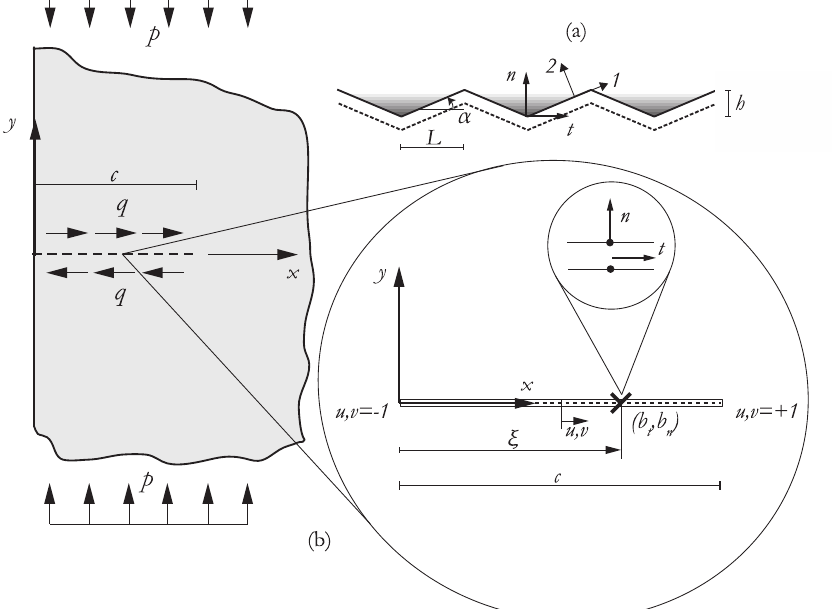
Figure 1: a) The saw-tooth asperity model, showing the local and global reference systems adopted in the formulation, Eqns. (1)-(4). b) Schematic model of the geometry with an edge crack of length c